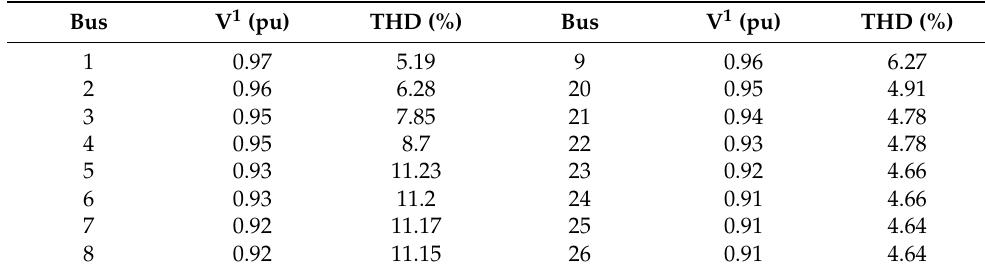
Figure 7. Single line diagram of the 18-bus IEEE test network containing one nonlinear load. Table 2. Network voltages when a 3 MW 2.25 MVAr six-pulse converter is implemented.